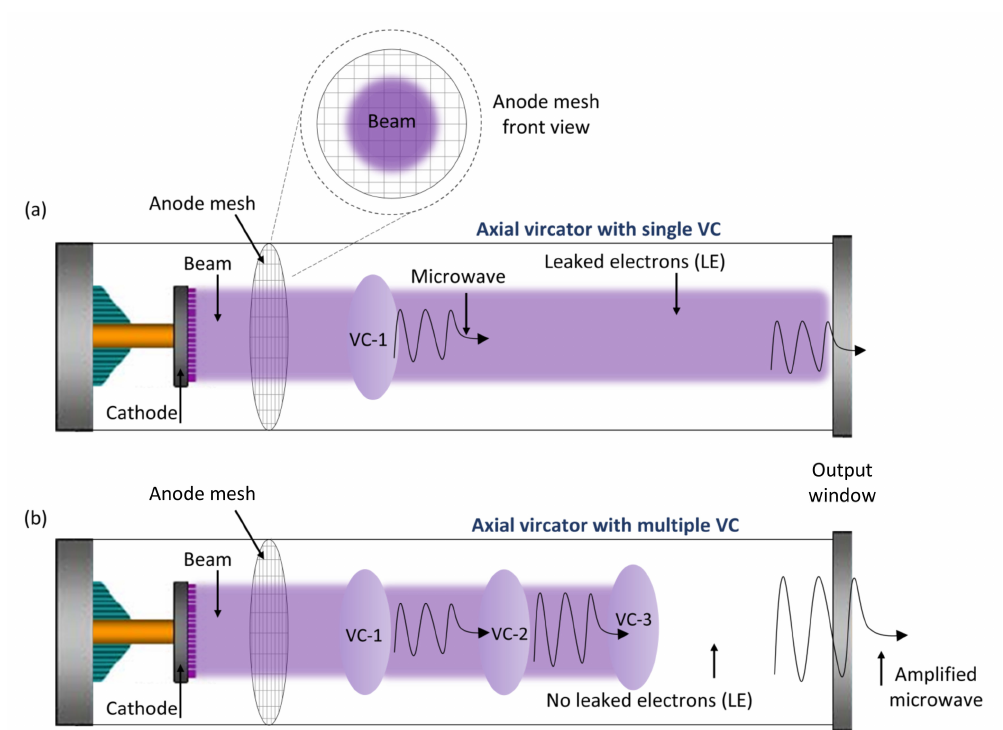
Figure 1. The axial vircator is depicted schematically with single and multiple VCs. ( a ) The conven- tional axial vircator, when a single VC fails to confine all the beam electrons and electrons propagate to the downstream region indicated by LE. There were few or no beam-wave interactions in the downstream region, and the microwave remained unchanged. ( b ) On the other hand, multiple VCs in the downstream region positively influenced the microwave when it interacted with the charge of multiple VCs in the downstream region, and an amplified power of the microwave was